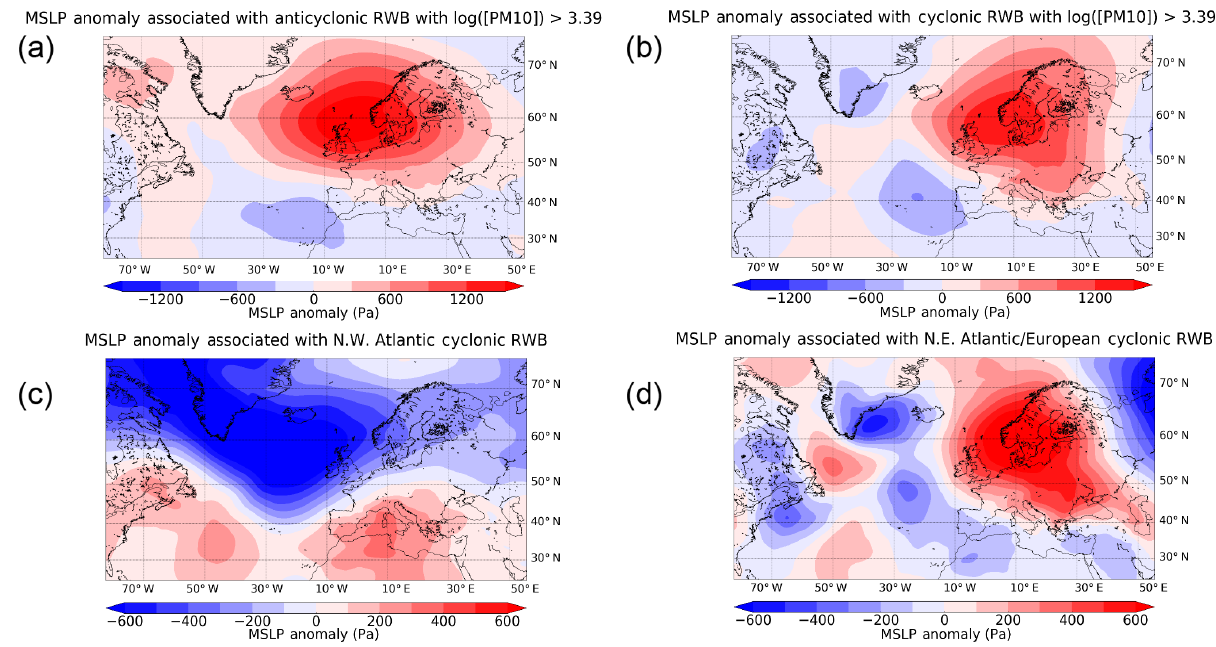
Figure 4. (a) and (b) Composite MSLP anomaly on the day following days incorporating anticyclonic RWB and cyclonic RWB within the regions of predefined influence (see Fig. 3) respectively, and on the day following RWB, ln[PM 10 ] > 3.39. (c) and (d) MSLP anomaly on the day following days incorporating cyclonic RWB within the regions of predefined influence in the northwest Atlantic and northeast Atlantic–European sectors respectively, regardless of [PM 10 ]. Pressure data were taken for the winter months (DJF) between January 1999 and December